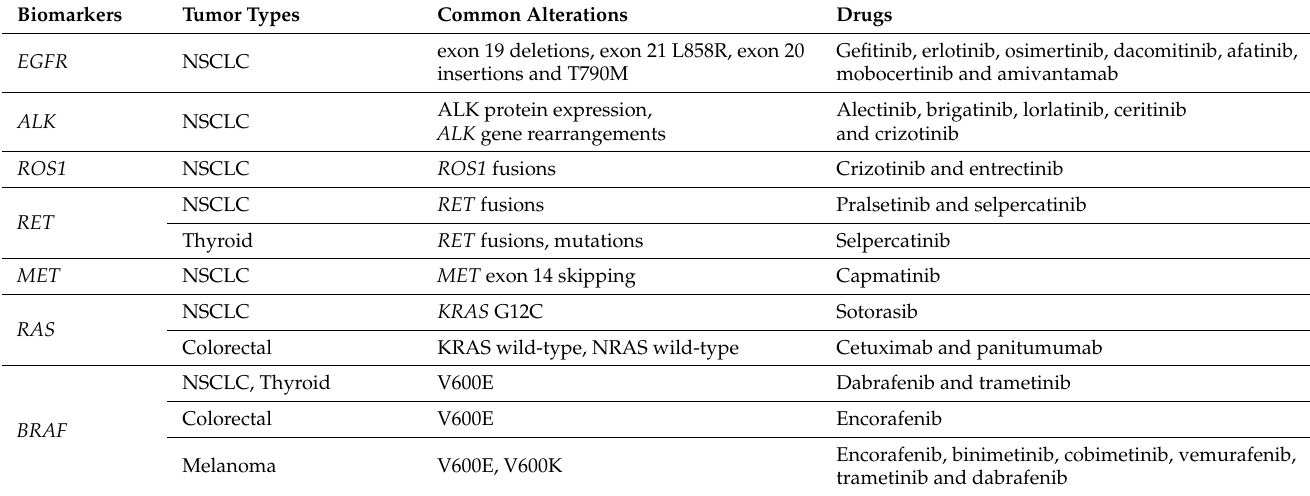
Table 1. Tumor-agnostic mutations and molecular-targeted drugs approved by the Food and Drug Administration